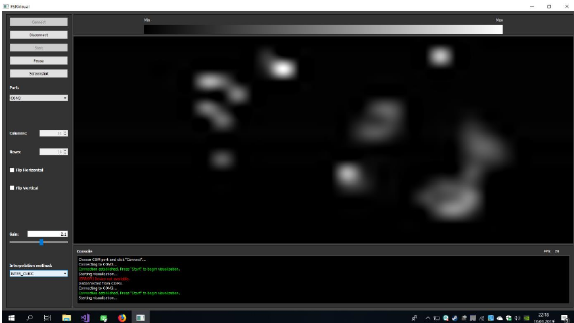
Figure 6. An example of visualization of measurement data from one layer (one FSR matrix).